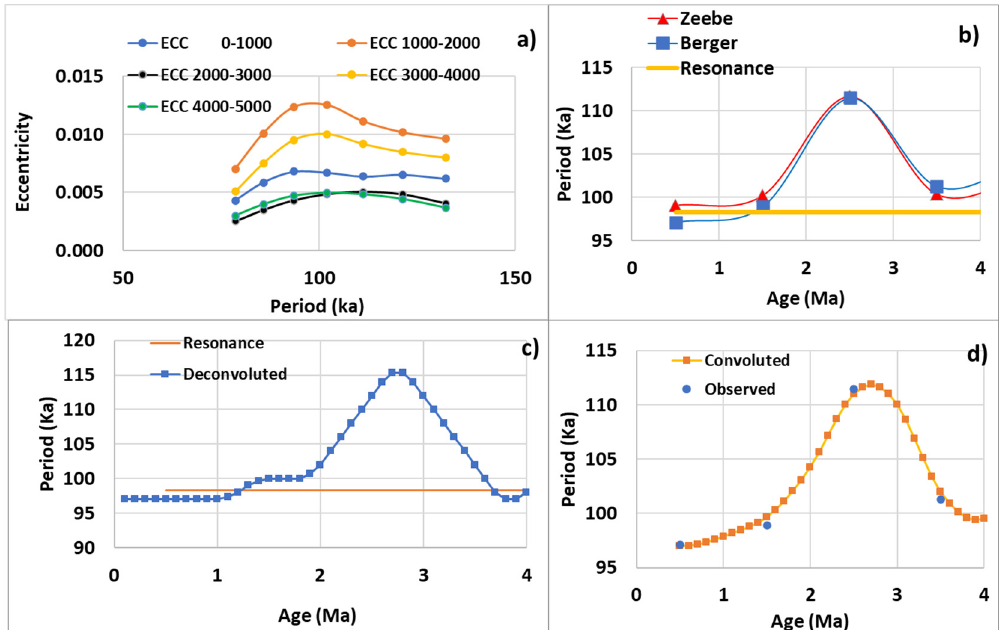
Figure 3. Variations in the period of eccentricity in the vicinity of 100 Ka calculated from Berger and Loutre [47]—( a ) Fourier transform of eccentricity variations over 1 Ma time intervals—( b ) Periods vs. time observed at the maximums of the Fourier transforms in a). The same values calculated from Zeebe and Lourens [49] are also represented—( c ) Deconvoluted curve of the period vs. time represented in ( b )—( d ) Comparison of the moving average over 1 Ma of the deconvoluted curve in ( c ) and the period vs. time in ( b ).